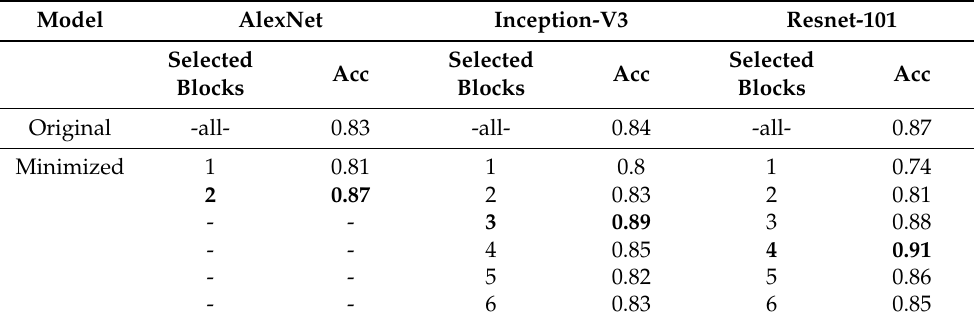
Table 4. Results of pre-trained model while using full and partial architectures.